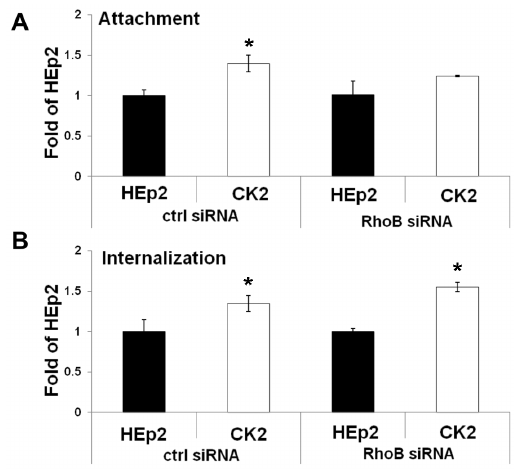
Figure 5. Decreasing RhoB expression by siRNA transfection does not change Ad5wt attachment or internalization. Forty-